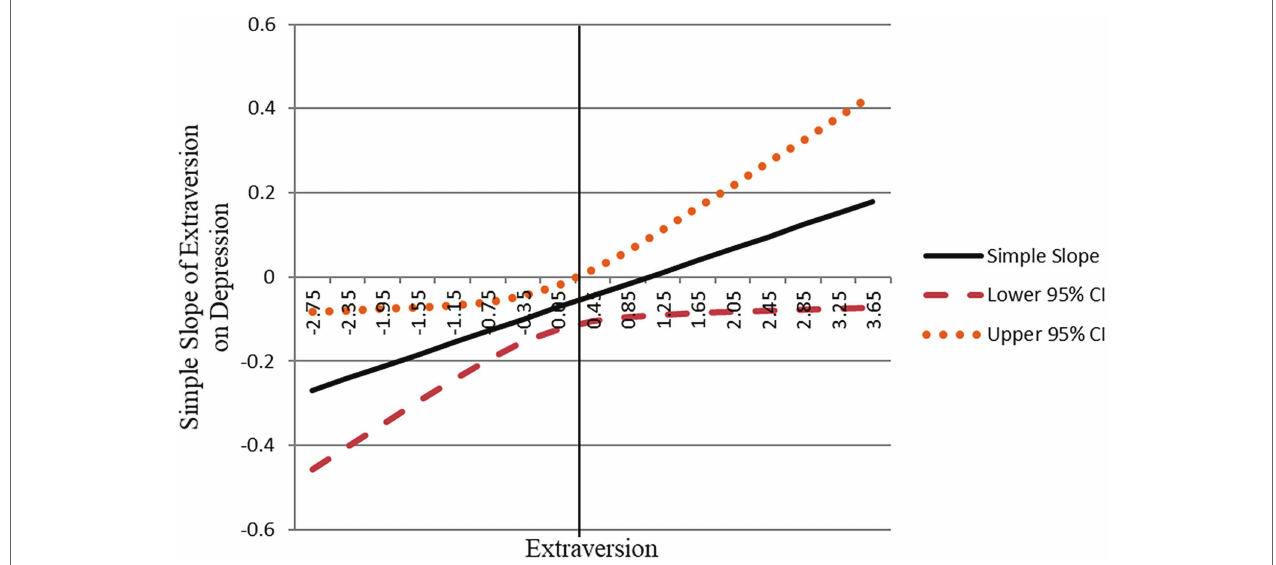
FIGURE 4 | Johnson–Neyman plot of the region of significance for the simple slope of extraversion on